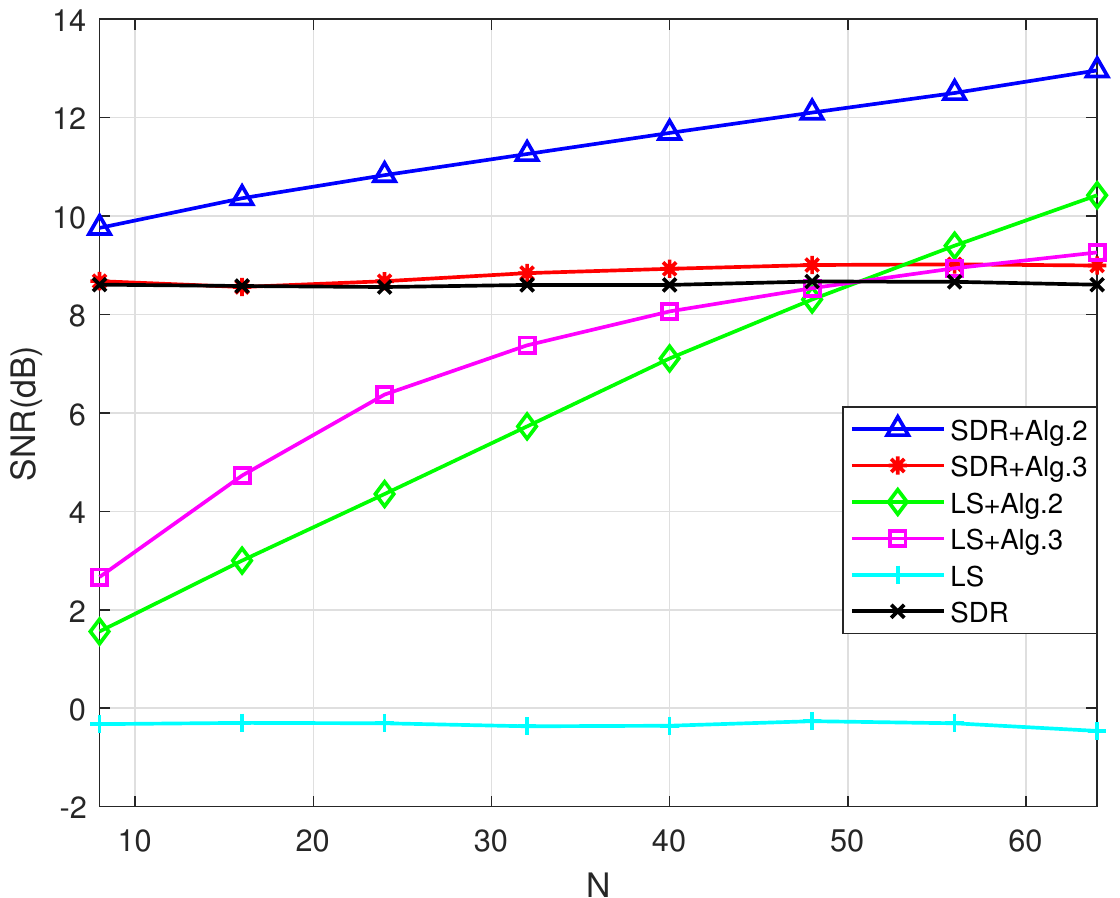
Figure 3. SINR performance comparison over the number of reflecting elements N in the overloaded case. Here, P = 10, M = 4 and K =